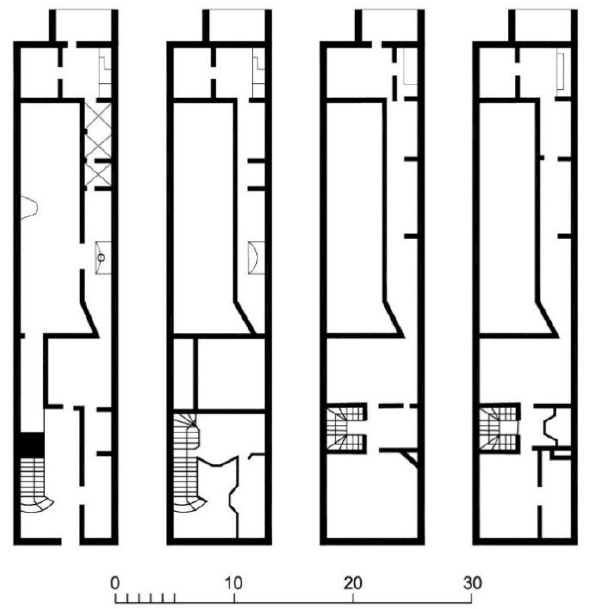
Figure 1. Uphagen House, Gda´nsk, 12 Długa Street, ground floor plans, mezzanine, first and second floors [39].